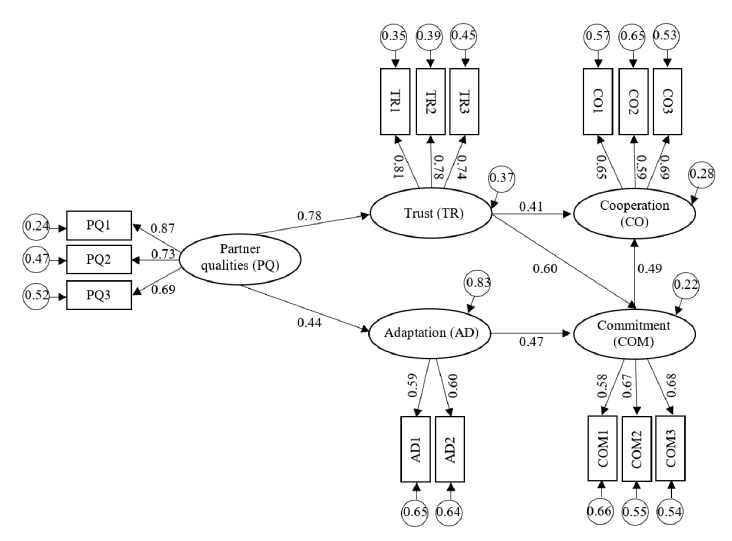
Figure 4. Structural